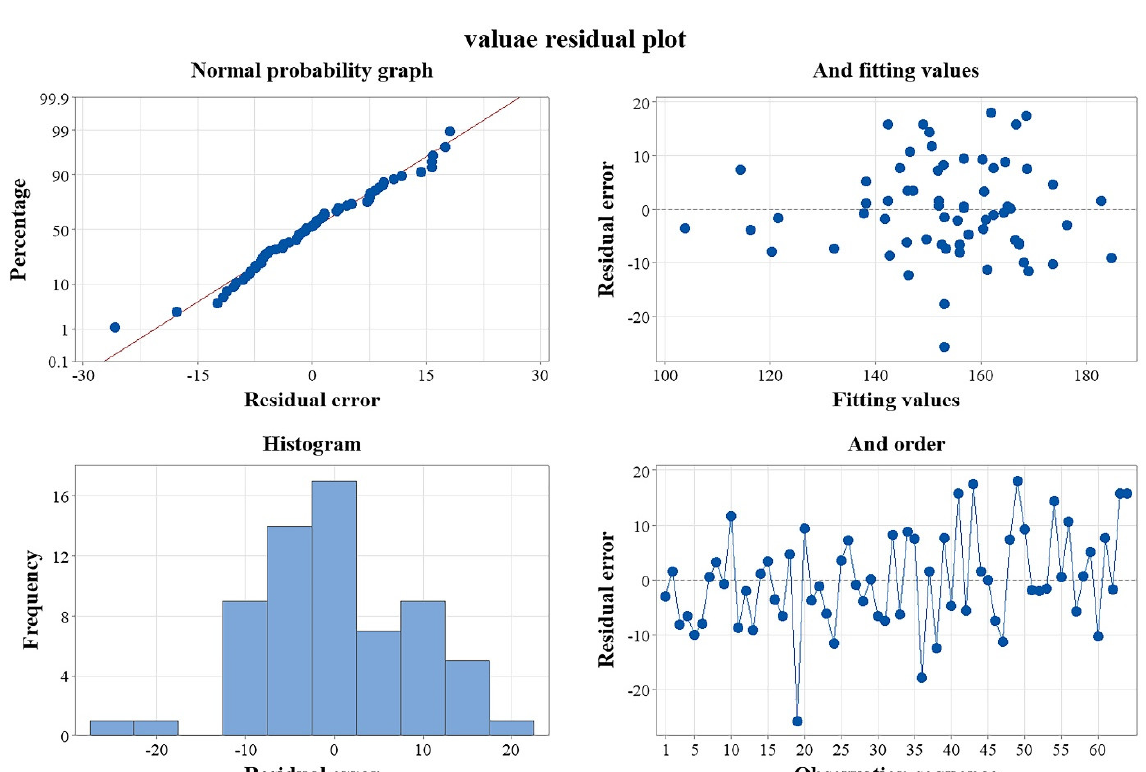
Figure 2. Reliability test of factorial analysis between polystyrene 5 polymer and biodegraded protein under the combination scheme of plastic additives.